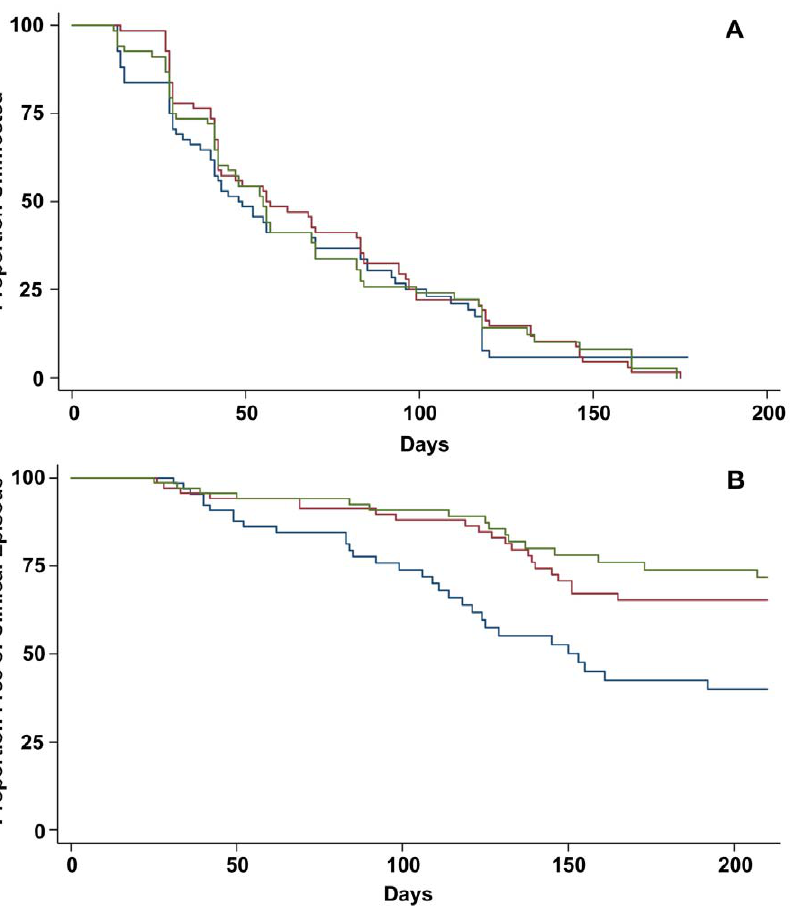
Figure 4. PfMSP1-19 specific IgG levels measured by ELISA and association with protection from malaria or re-infection. ( A ) Kaplan- Meier curve showing the association between PfMSP1-19 specific (PfMSP1-19 minus PcMSP1-19) IgG by ELISA and time to reinfection detected by PCR for low (blue), medium (red) and high (green) responders. ( B ) Kaplan-Meier curve showing the association between low, medium and high levels of PfMSP1-19 specific IgG and risk symptomatic malarial episode (fever + Pf . 5000/ m